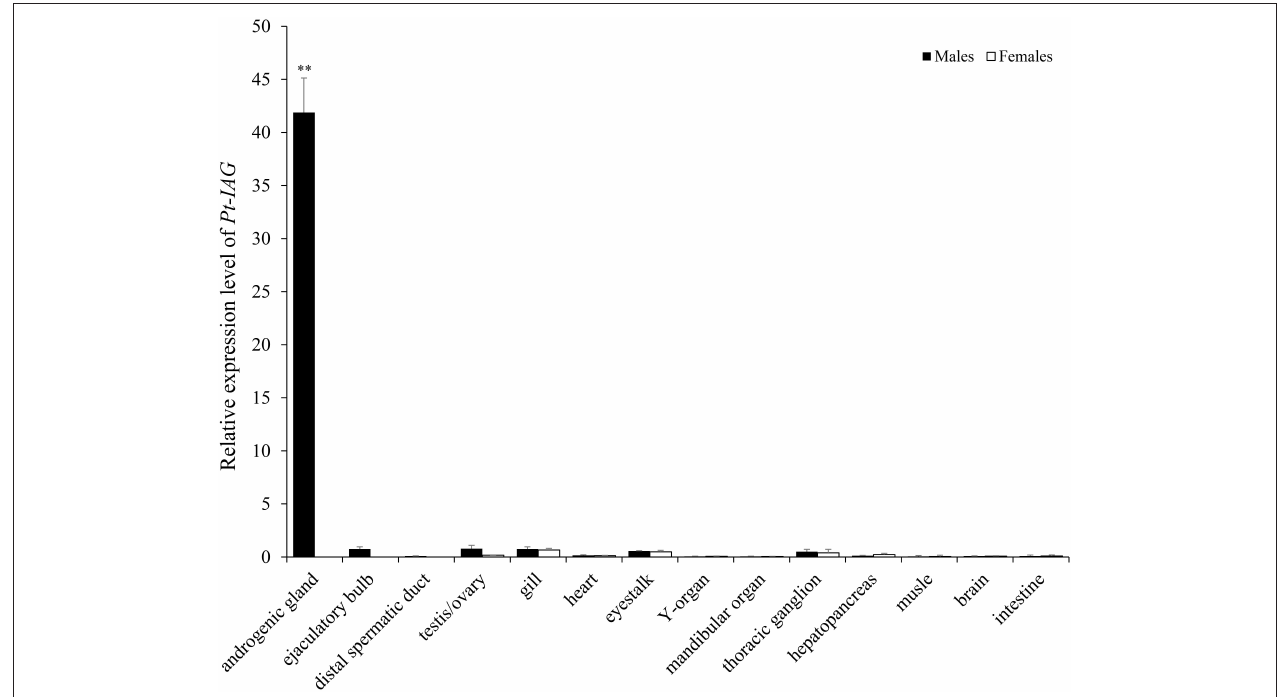
FIGURE 1 | Tissue distribution of the insulin-like androgenic gland hormone of Portunus trituberculatus ( Pt-IAG ) transcripts. Bars represent mean ± SEM ( n = 4). **Values statistically different from other groups ( P < 0.01, Student’s t -test).